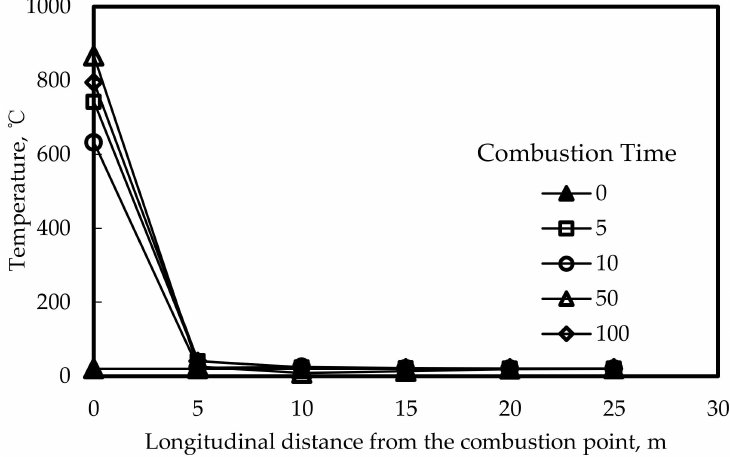
Figure 7. Distribution of the temperature along the longitudinal